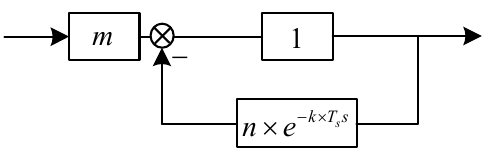
Figure 4. Structure of zero-gain first-order lead link.